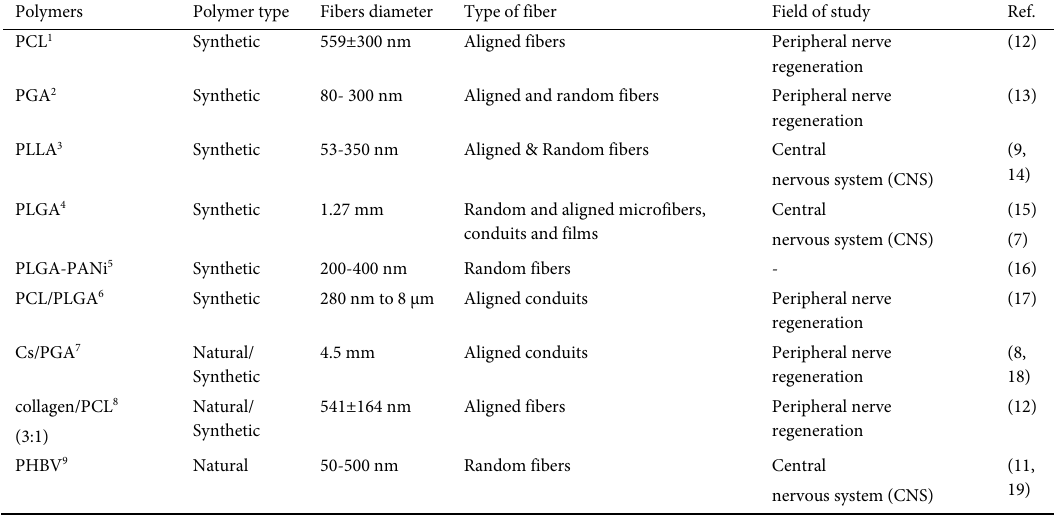
Table 1. 1 Poly(caprolactone), 2 poly(glycolic acid), 3 Poly L-Lactic acid, 4 Poly(lactic-co-glycolic acid), 5 Poly(lactic-co-glycolic acid)/Polyaniline, 6 Poly(caprolactone)/Poly(lactic-co-glycolic acid), 7 Chitosan/poly(glycolic acid), 8 Collagen/Poly(caprolactone), 9 Poly(3-hydroxybutyrate-co-3- hydroxyvalerate)